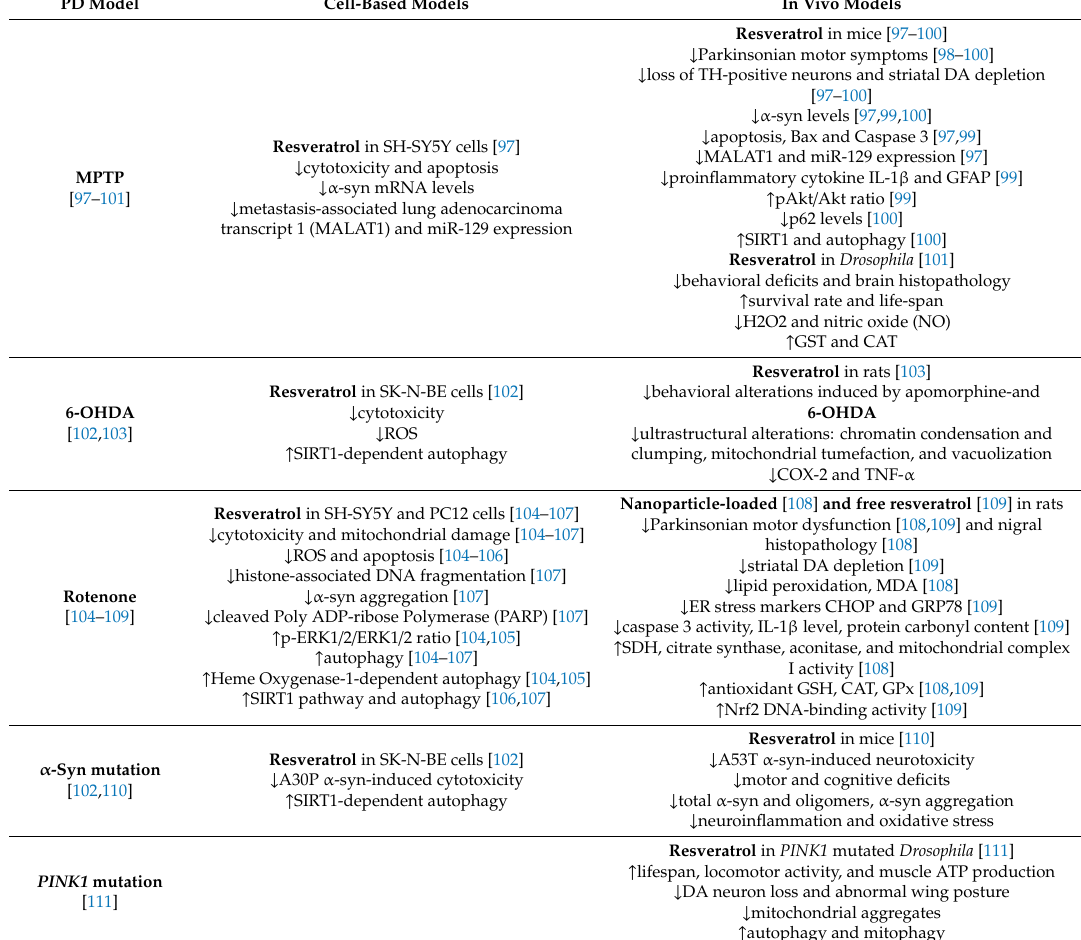
Table 6. Neuroprotective e ff ects of resveratrol in PD